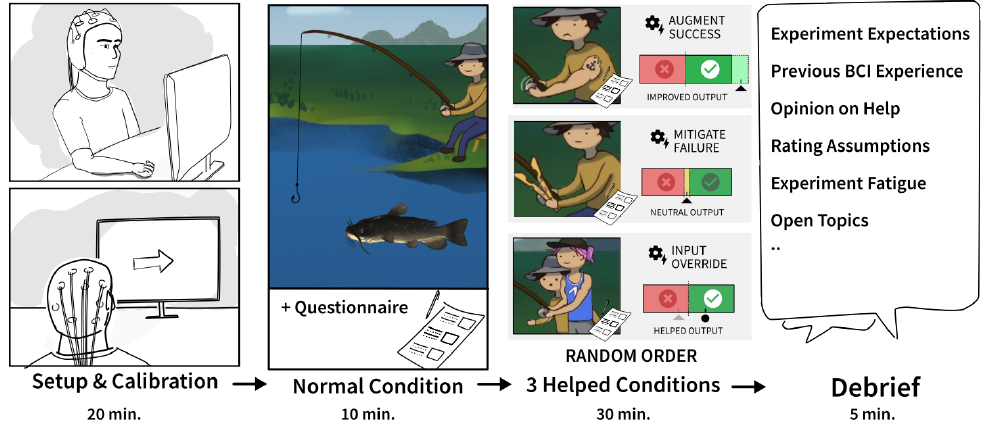
Figure 4. Each participant in the experiment (1) underwent BCI setup and BCI calibration, (2) played a fishing game in four conditions, starting with the normal condition, followed by (3) three helped conditions in a shuffled order. Participants were then debriefed about their